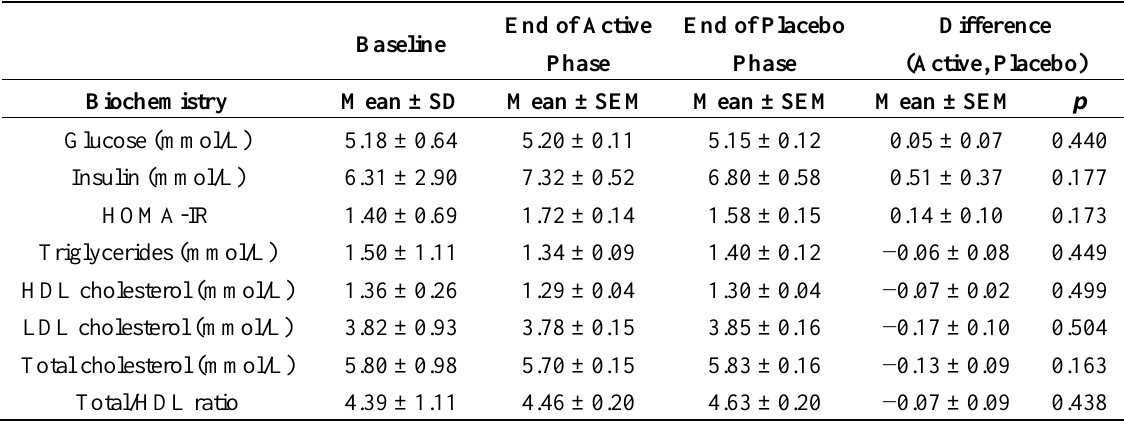
Table 3. Blood biochemistry: total, HDL and LDL cholesterol, triglyceride, glucose and insulin and HOMA-index of insulin resistance at baseline and the end of each phase ( n =